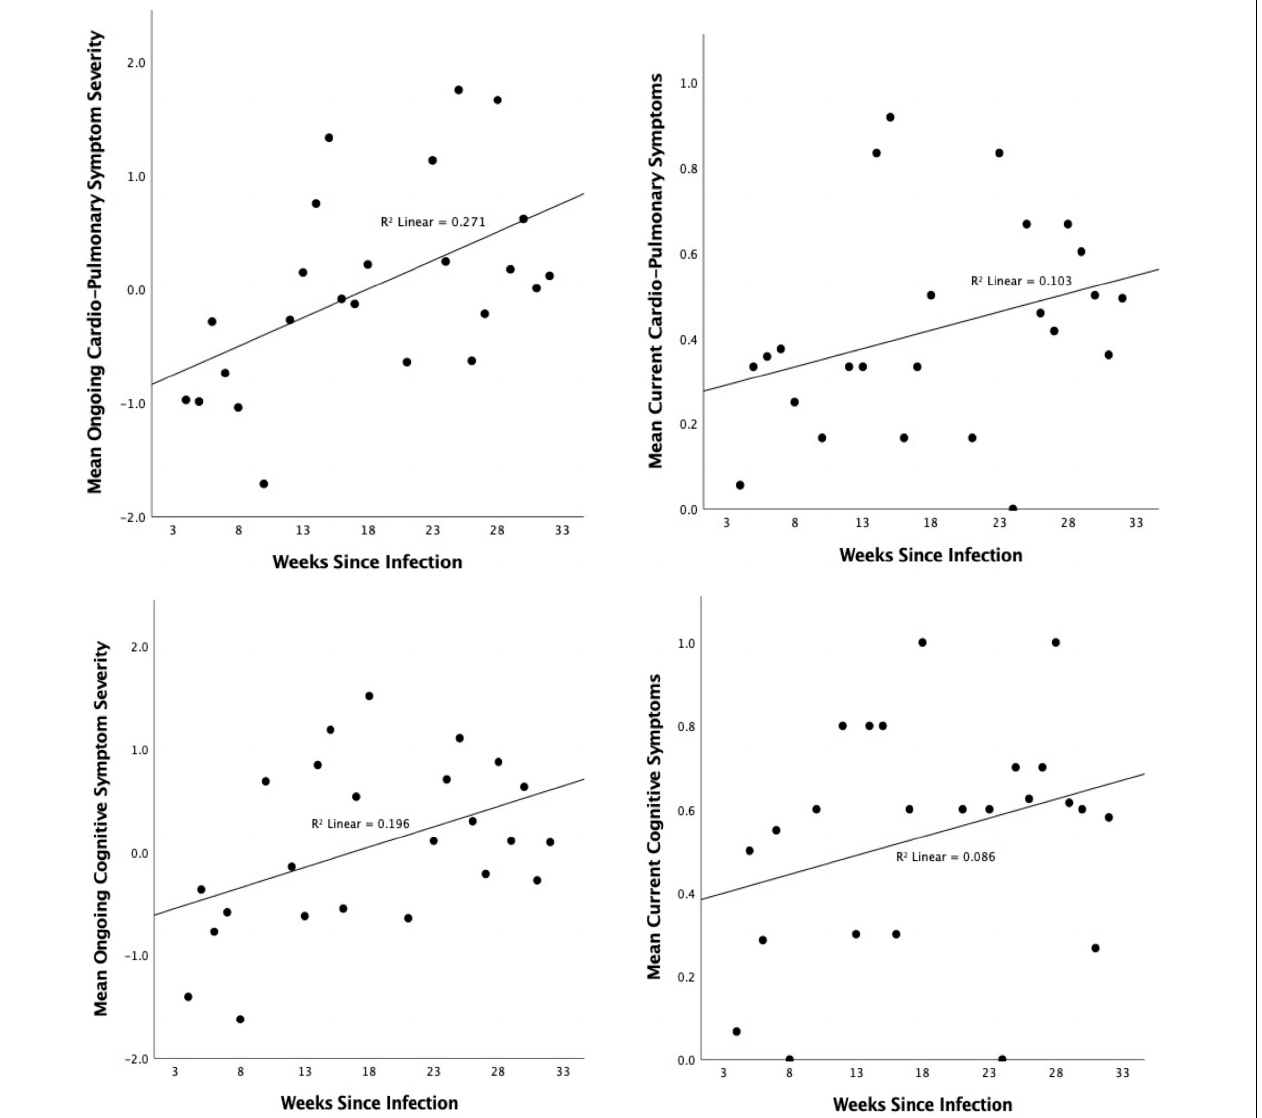
FIGURE 7 | Association between number of weeks since infection and severity of (top) Cardiopulmonary/Fatigue Symptoms and (bottom) cognitive symptoms in the entire period since the initial infection (left) and the past 1–2 days (right) . Higher scores indicate higher symptom